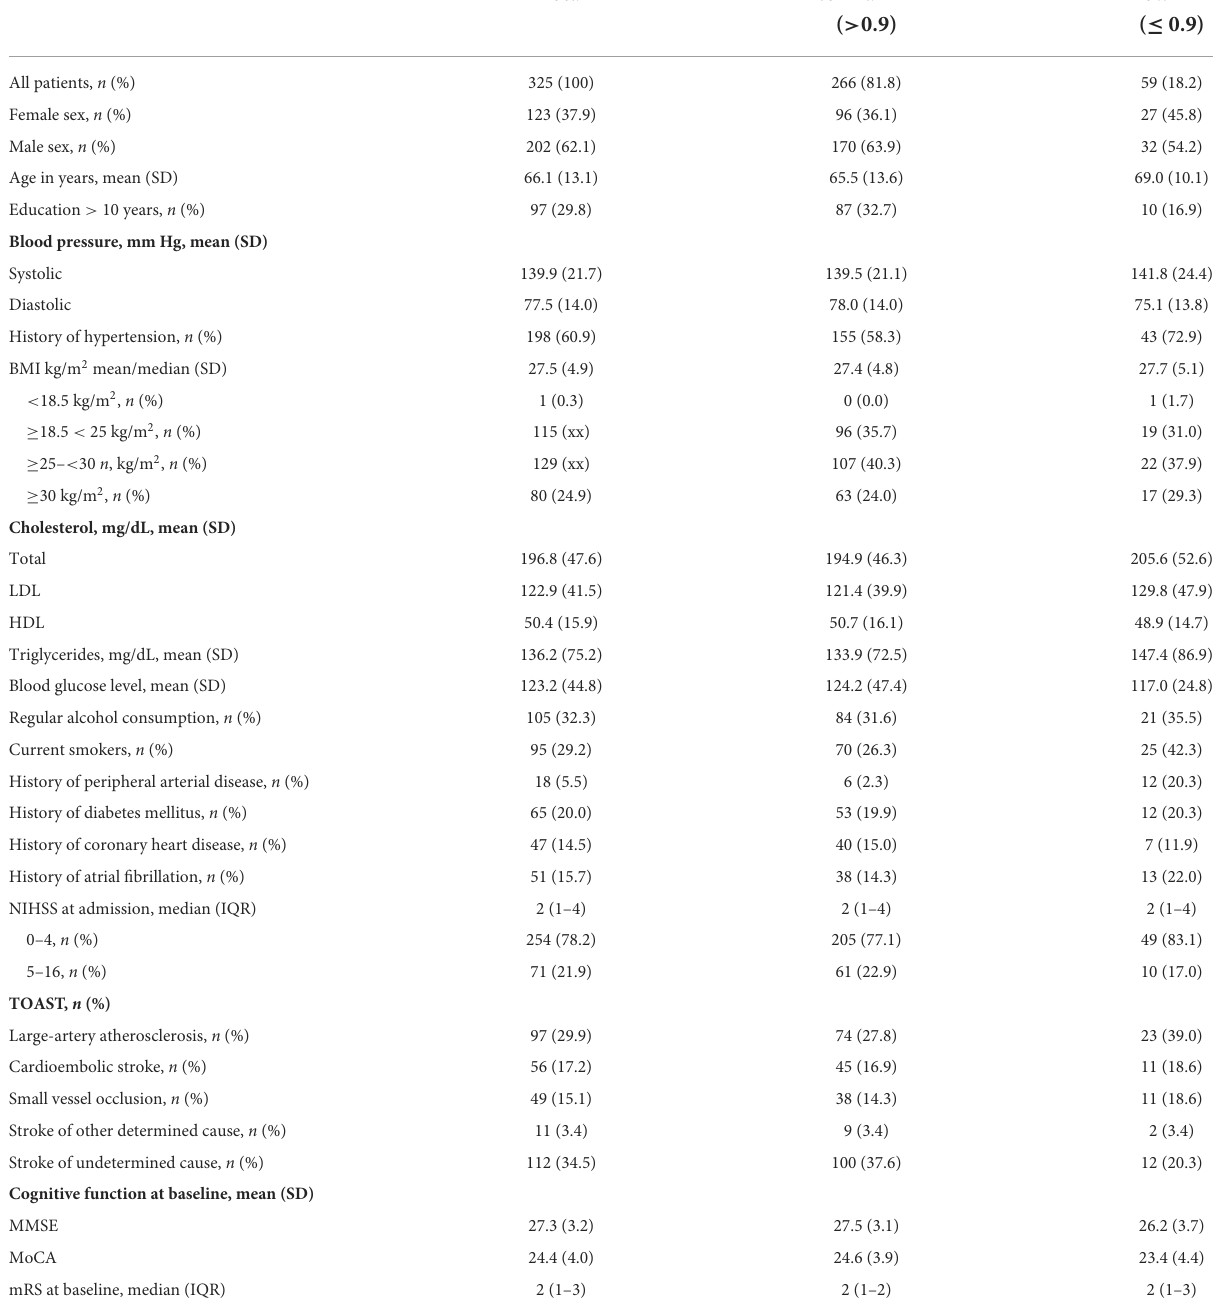
TABLE 1 Demographic baseline characteristics according to ankle-brachial index.